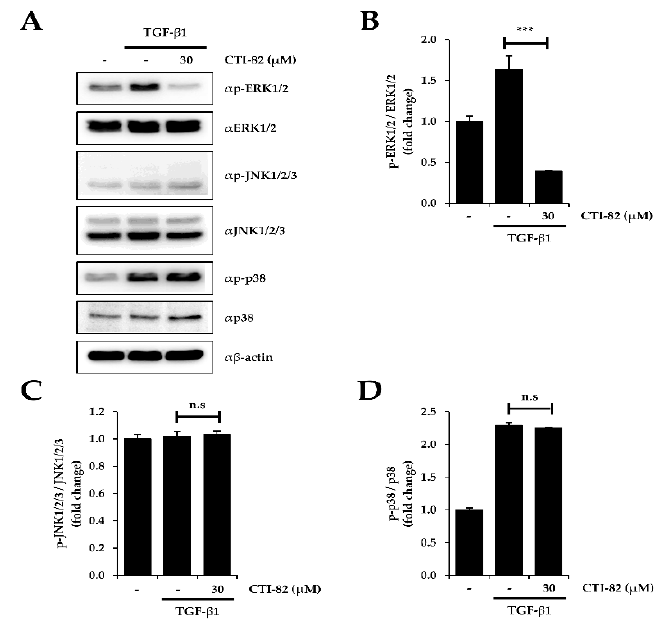
Figure 4. Effect of CTI-82 on mitogen-activated protein kinase (MAPK) signaling pathway in TGF- β 1-treated A549 cells. ( A ) Protein expression of p-ERK1/2, p-JNK1/2/3 and p-p38. CTI-82 attenuates MAPK signaling induced by TGF- β 1. A549 cells were treated with TGF- β 1 for 2 h, followed by treatment with CTI-82 for 48 h. Western blot analysis was performed with cell lysates. The graphs show densitometric quantification of p-ERK1/2 ( B ), p-JNK1/2/3 ( C ), and p-p38 ( D ). *** p -value < 0.001 versus TGF- β 1 alone. ns; not significant. The data are expressed as the mean ± SD for triplicates. (The uncropped blots and molecular weight markers are shown in Supplementary Figure S1).